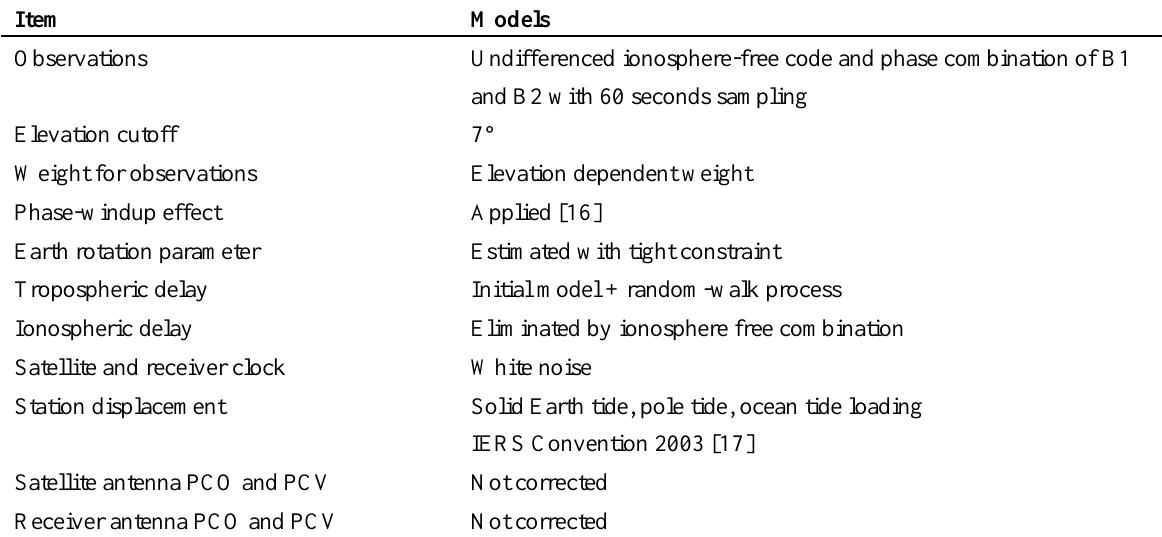
Table 2. Summary of observation models and parameters applied in POD.